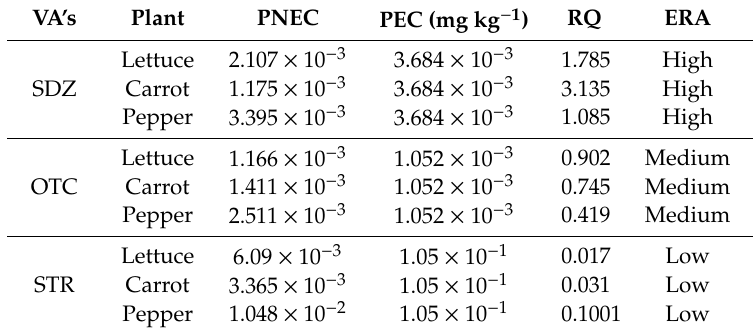
Table 6. Estimated risk quotients and corresponding levels of potential acute ecological